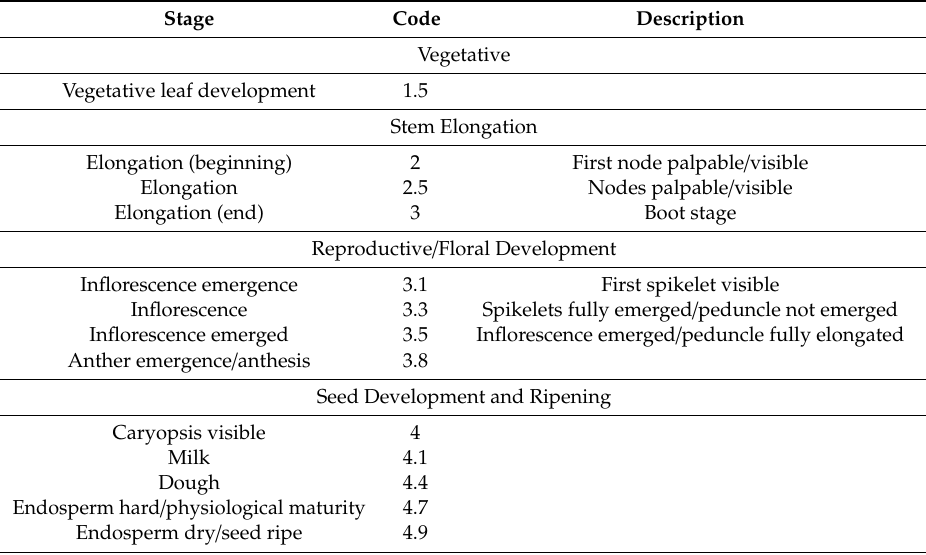
Table 1. Definition of the plant stages (in grasses) used to characterize the medium plant stage of the grasslands (adapted from